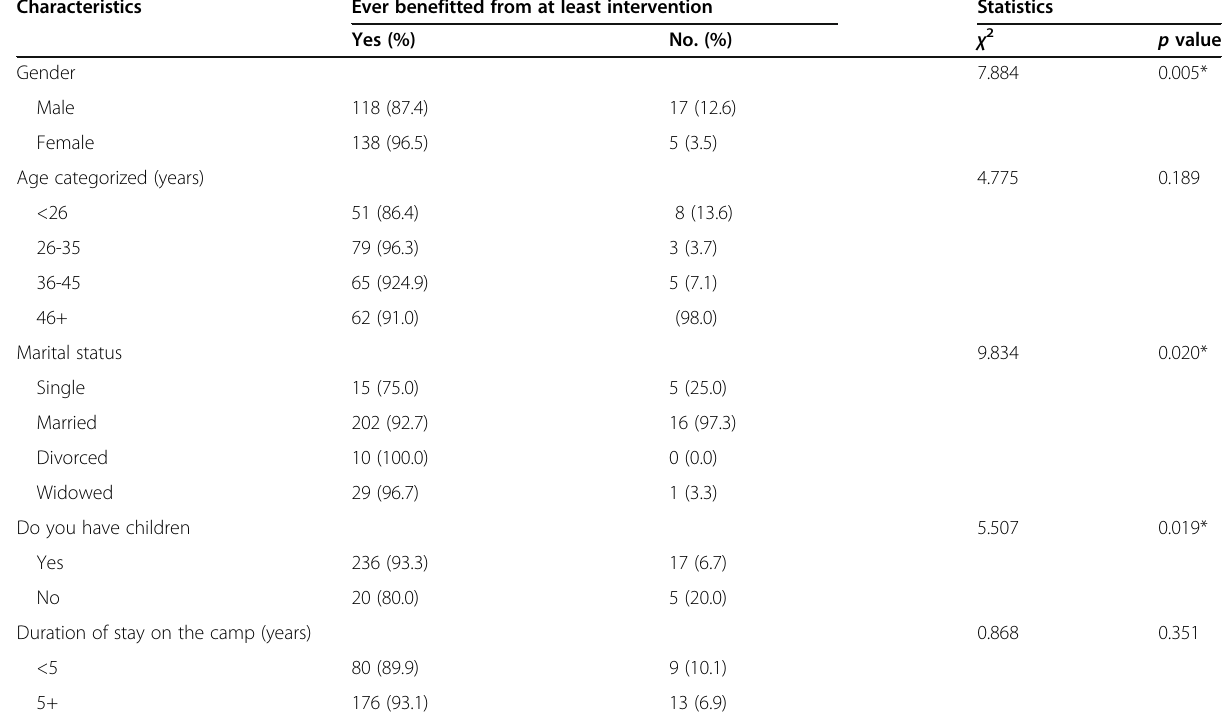
Table 2 Distribution of the participants who had ever benefitted from intervention provided in the camp ( n =256) Characteristics